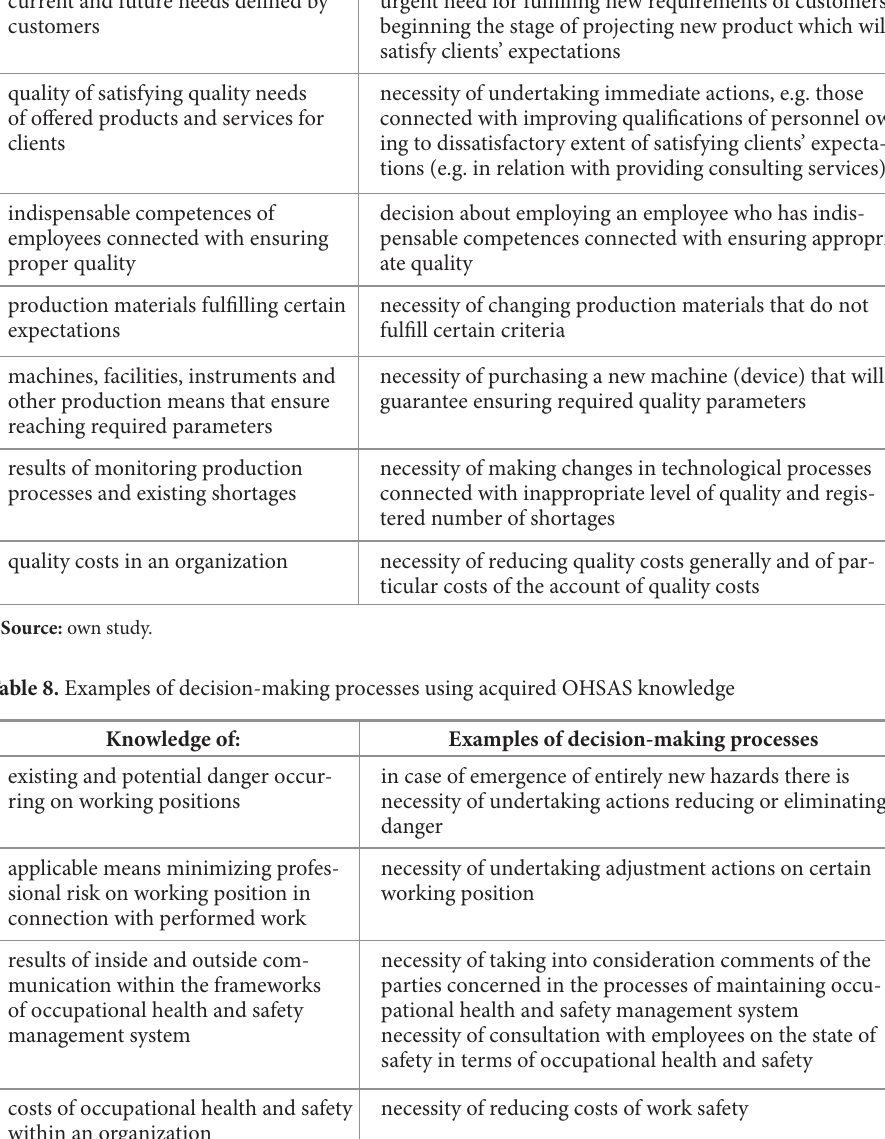
Table 7. Examples of decision-making processes using obtained knowledge within the frameworks of quality management system Knowledge of: